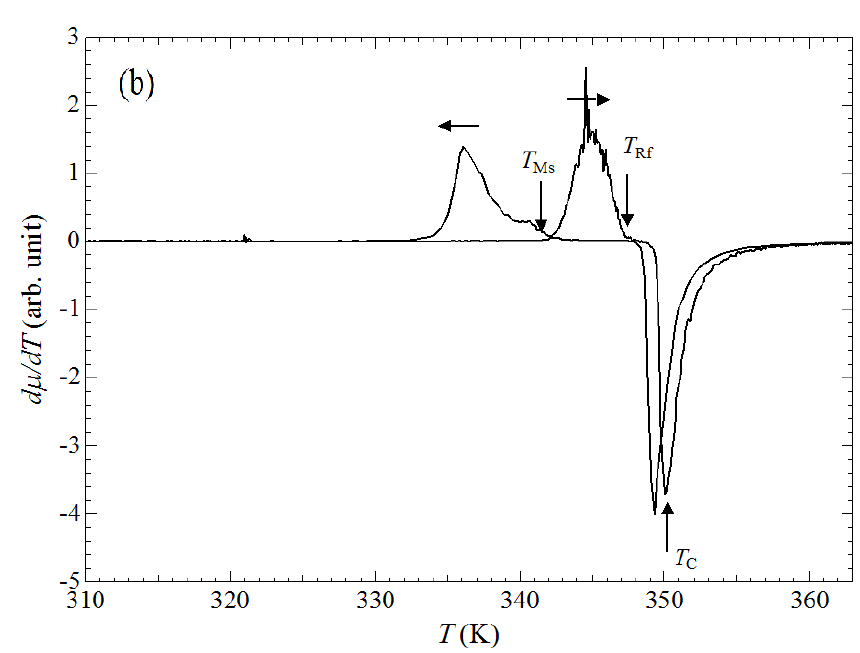
Mn Ga in static 52.5 24.5 23